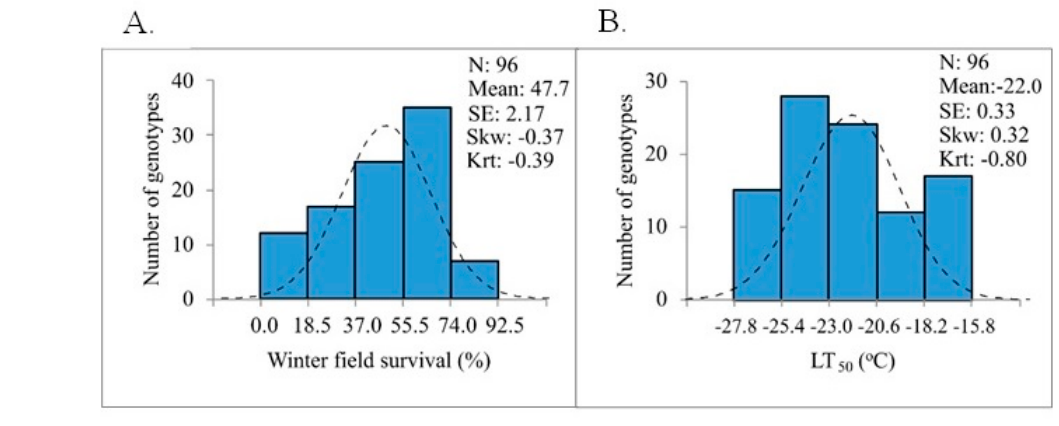
Figure 1. Distribution of frost hardiness determined for rye population of 96 accessions. ( A ) WFS (BLUE scores) determined from five years of field trials; ( B ) average LT 50 values determined from controlled freezing